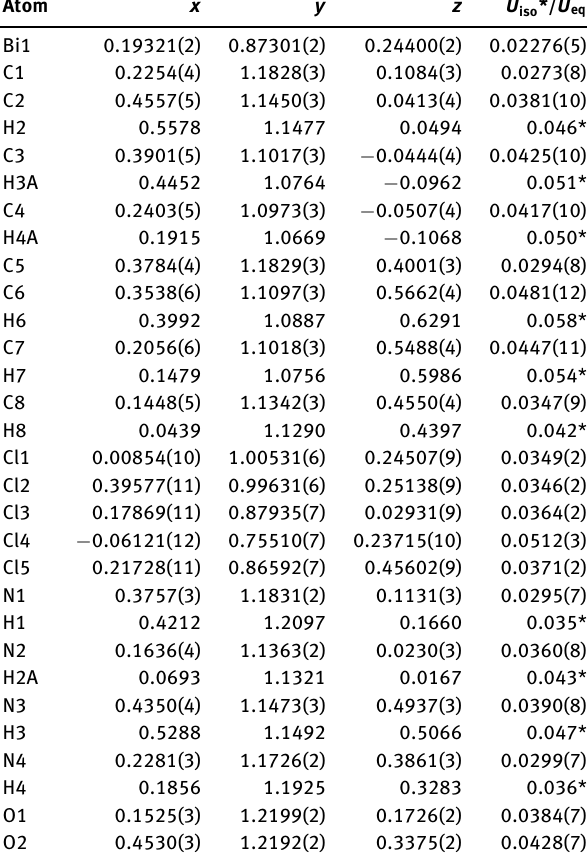
Table 2: Fractional atomic coordinates and isotropic or equivalent isotropic displacement parameters (Å 2